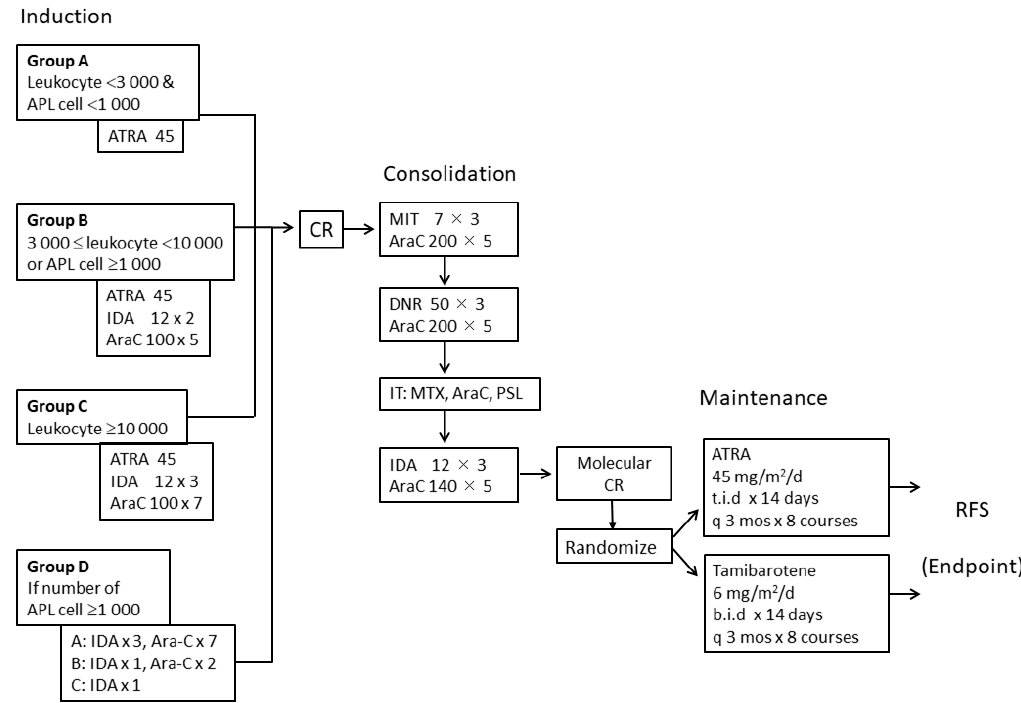
Figure 1. Scheme of the APL204 study. AraC, cytarabine; ATRA, all- trans retinoic acid; DNR, daunorubicin; IDA, idarubicin; MIT, mitoxantrone; MTX, methotrexate; PSL, prednisolone; IT, intrathecal injection; CR, complete remission; RFS, relapse-free survival.